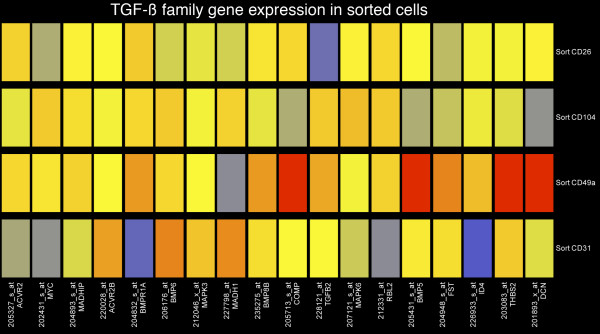
Cell type specific expression of TGFβ family members. A heatmap diagram of the expression profiles for genes that belong to the TGFβ and related signaling pathways. Red indicates high expression and blue indicates no detectable expression. Prostate stromal cells differentially express genes involved in TGFβ signaling relative to other prostate cell types.